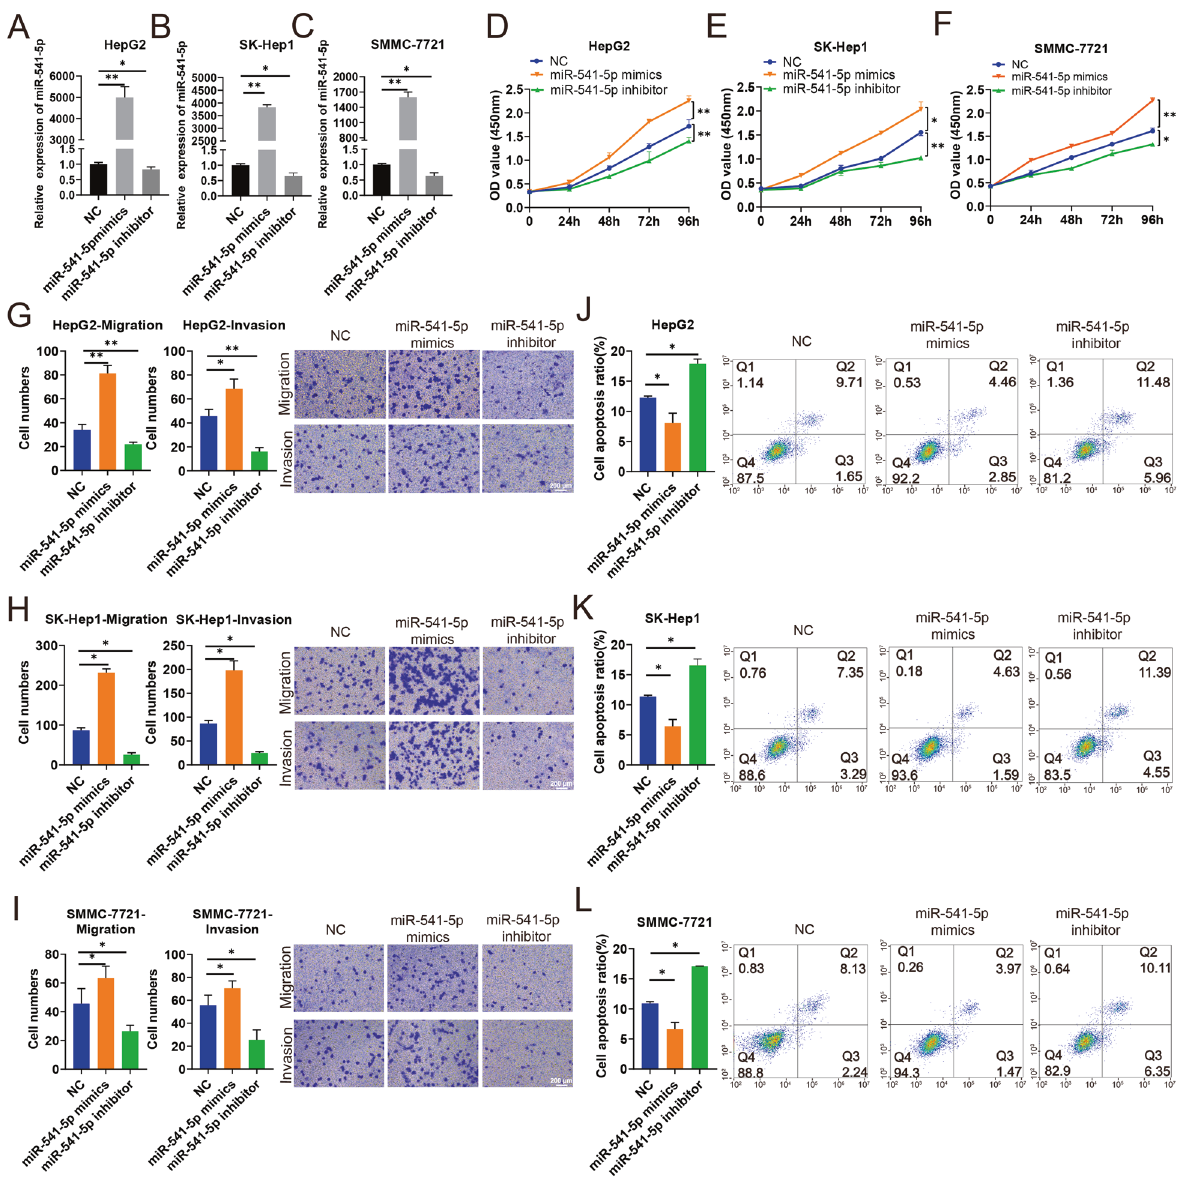
541-5p in HepG2, SK-Hep1, and SMMC-7721 cells. D – F Cell proliferation was detected in HepG2, SK-Hep1, and SMMC-7721 cells using CCK-8 assay. G – I Effect of miR-541-5p on migration and invasion were assessed using transwell migration and invasion assays; Scale bar, 200 μ m. J –